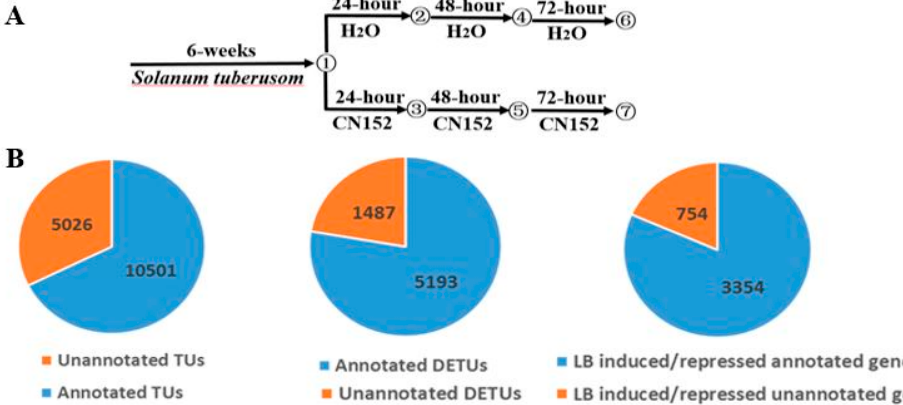
Figure 2. ( A ) A schematic showing the experimental design and the 16 sampling points. ( B ) Pie charts of the expressed TUs, differentially expressed TUs identified by pair-wise comparisons, and genes